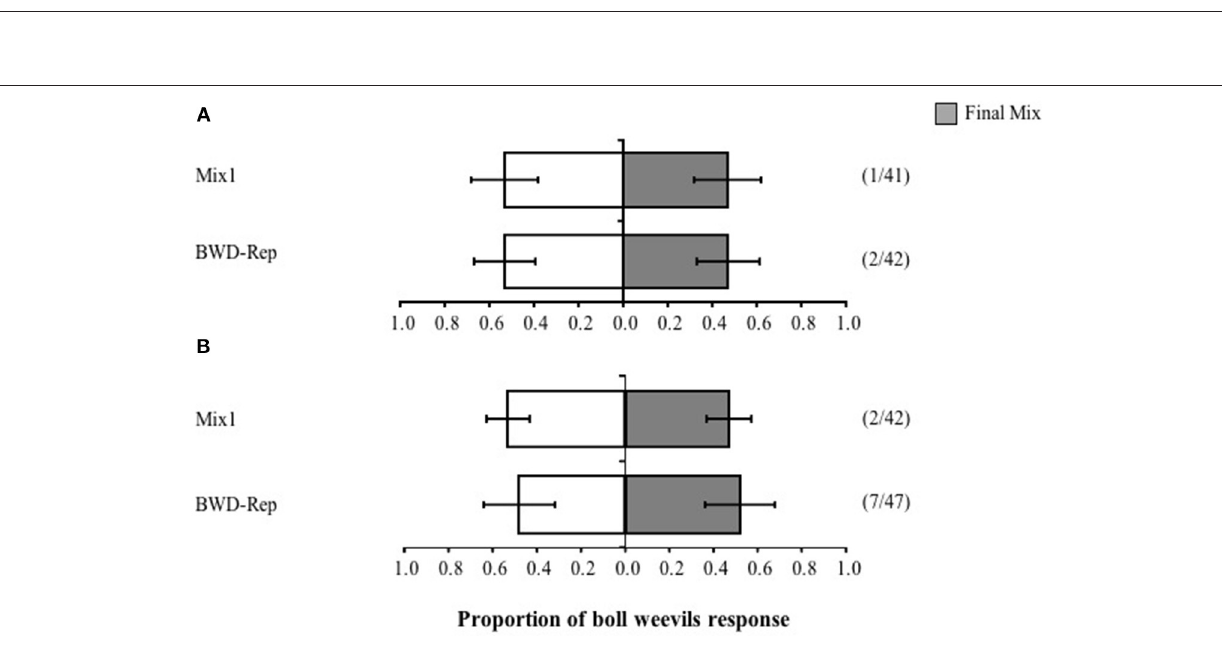
Frontiers in Ecology and Evolution | www.frontiersin.org